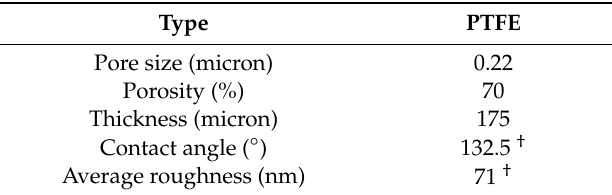
Table 2. Characteristics of the membrane applied in this study.